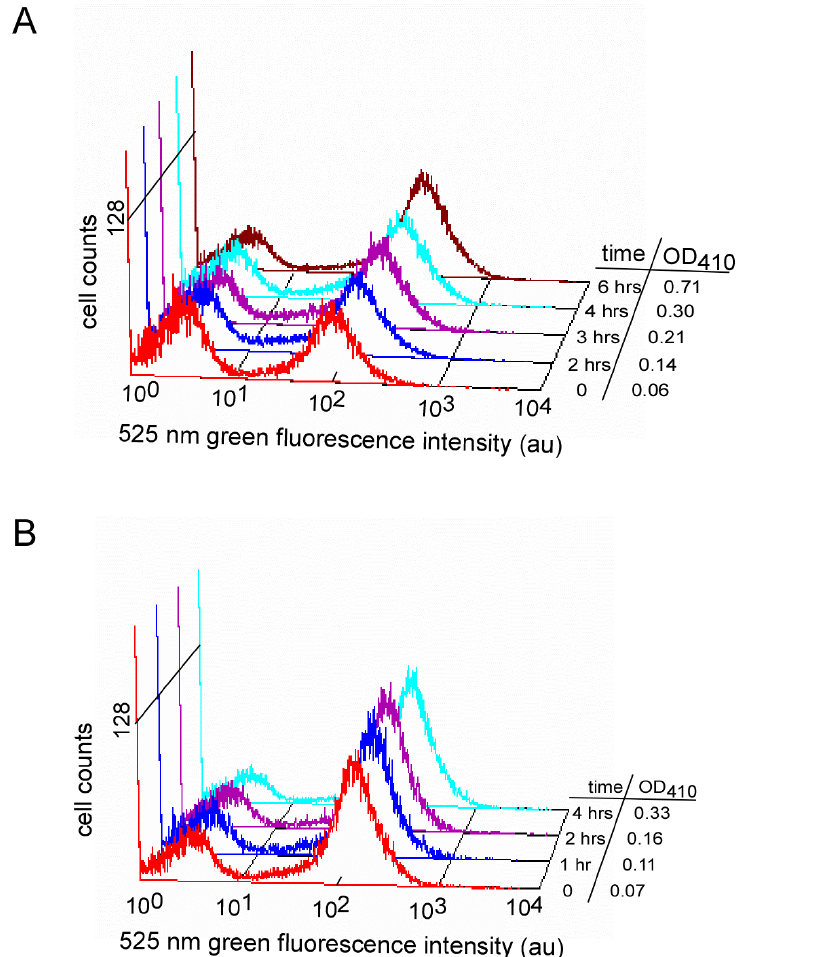
Fig. 4. Time course for single-cell profiling of PhoB activation by ArcB. Single colonies for E . coli strains carrying a phoAp - gfp fusion were grown in 1 % glycerol MOPS medium with 1 m M L-rhamnose for 10 hours from a low cell density. Cultures were periodically sampled for cell density and green fluorescence, by flow cytometry, as described in Materials. Cultures of E . coli BW31815 (like BW26910, except rhaBp - arcB ∆ arcA ) were inoculated from starter cultures that had been grown without (A) or with L-rhamnose (B). Analogous experiments were carried out with BW31820 (like BW26910, except rhaBp-arcB ∆ arcA ∆ ( ackA pta